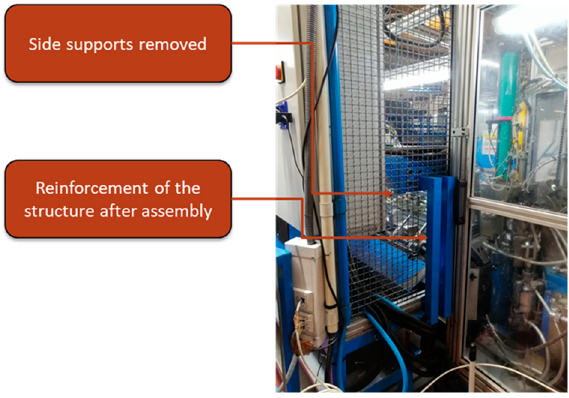
Figure 21. Structure of the robotic manipulator after the changes.